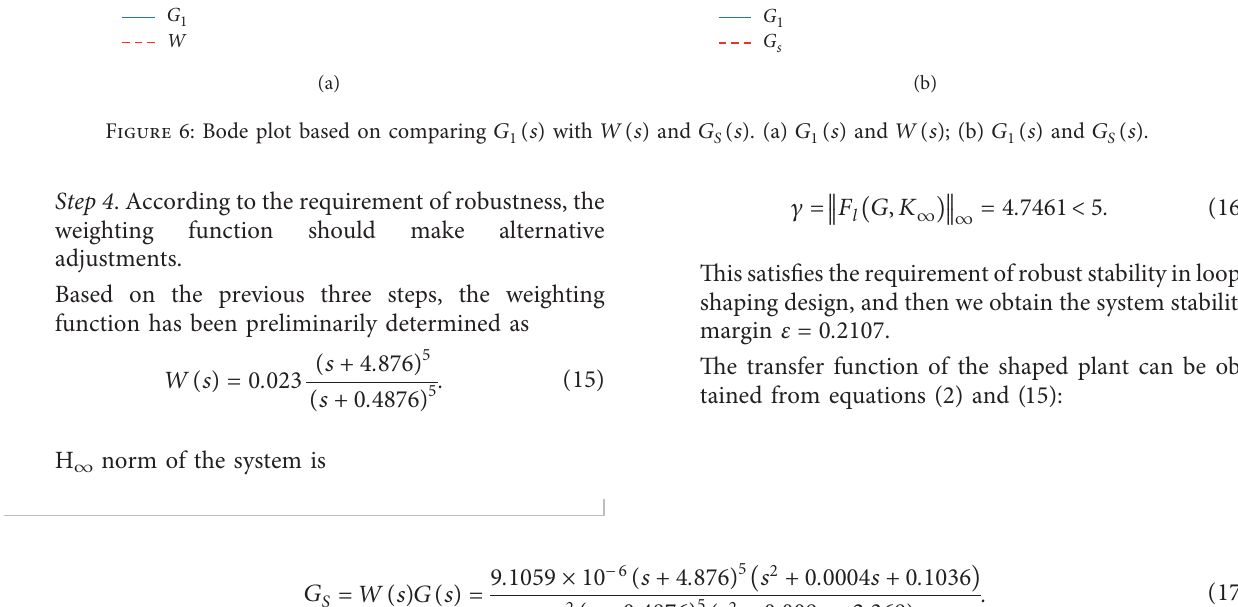
( s ) with W ( s ) and G 1